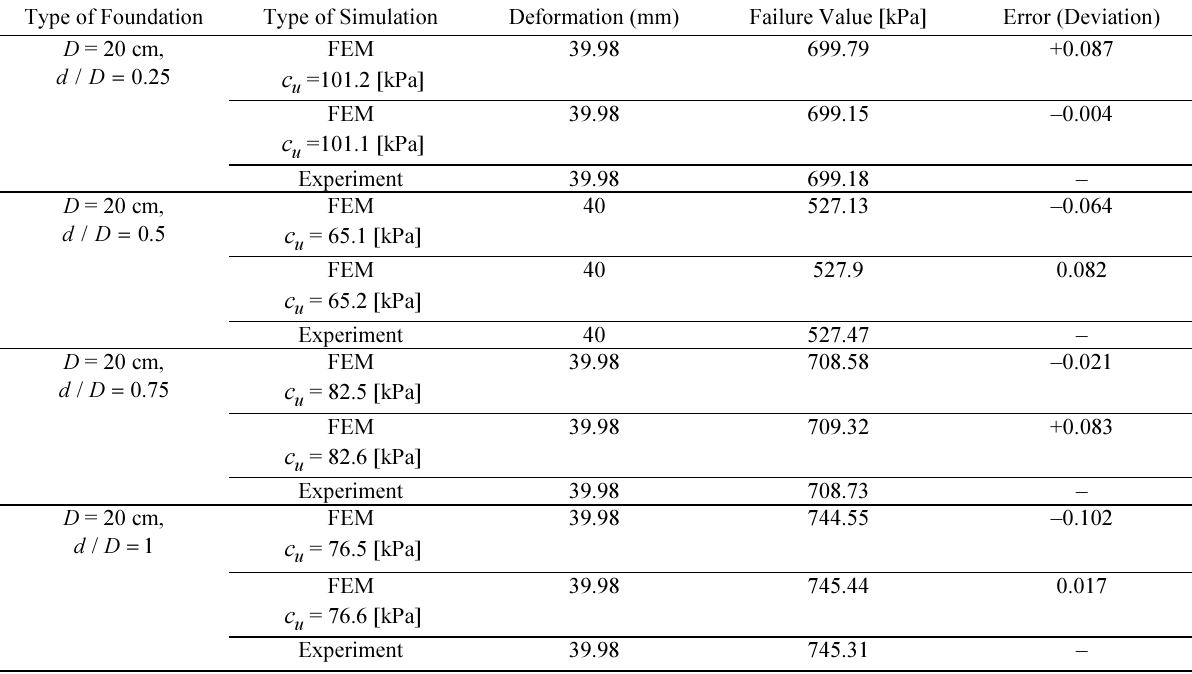
Table 9. Results of best-fit finite element